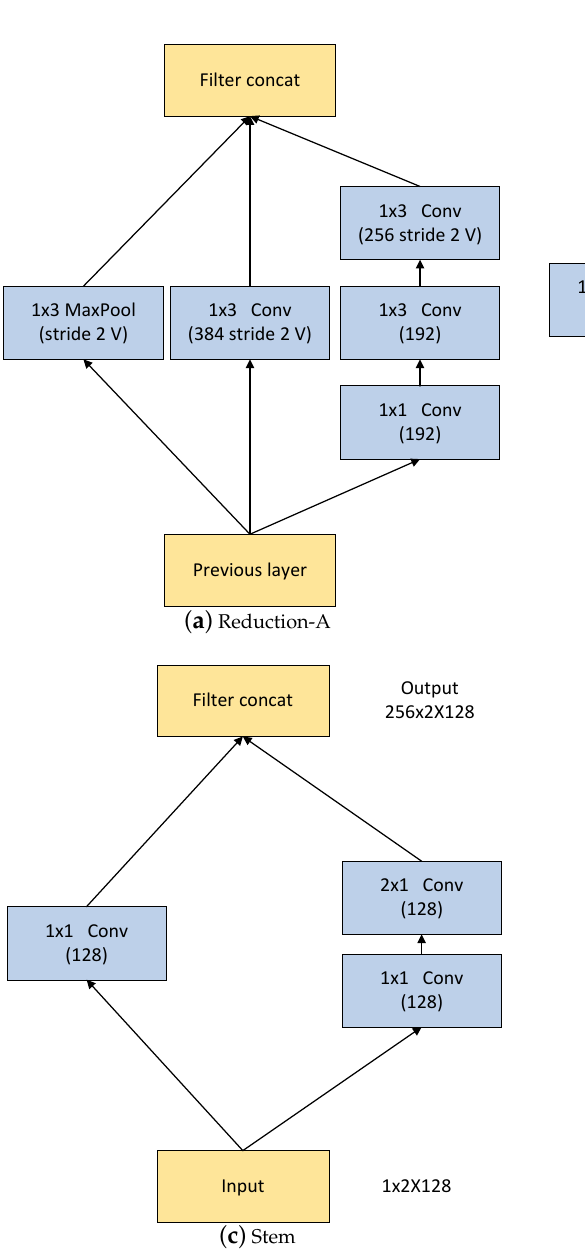
Figure 10. Structures of reduction blocks and